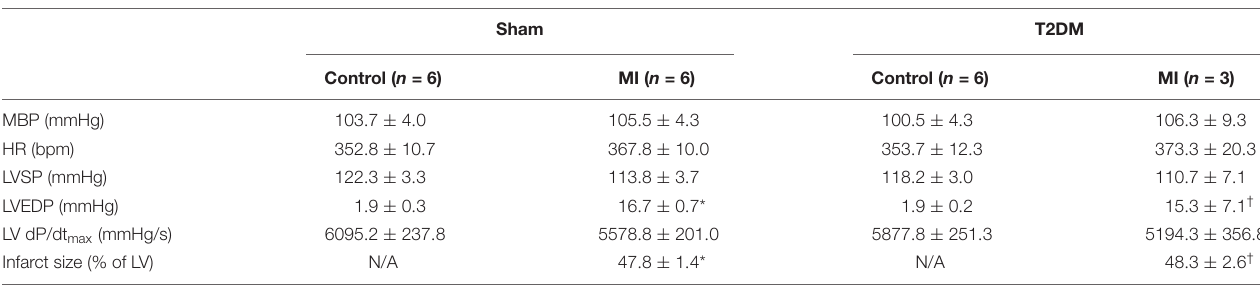
TABLE 1 | Hemodynamic and morphological characteristics in all groups of